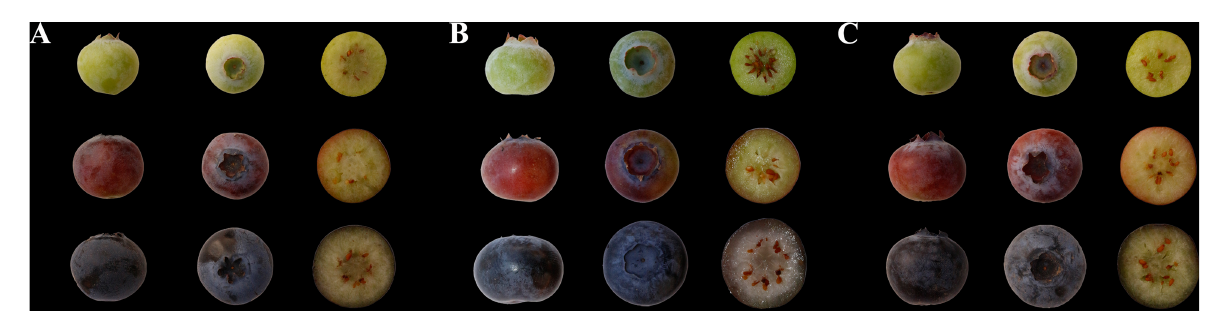
FIGURE 1 Green, pink, and blue stages of Misty, Duke, and Emerald. (A) Misty, (B) Duke, and (C)